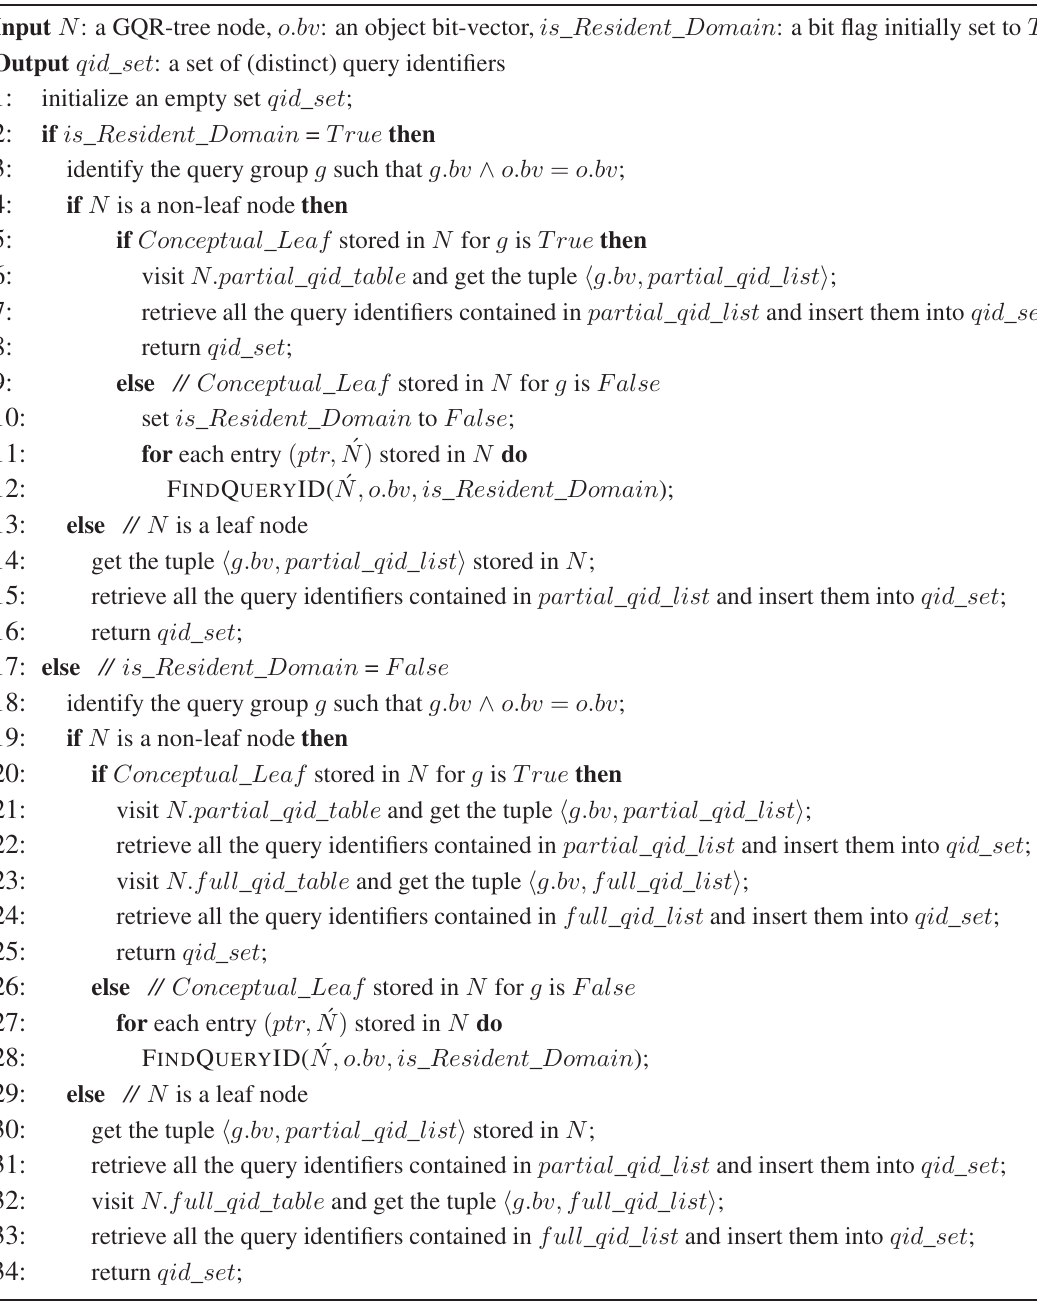
Algorithm 2 F IND Q UERY ID ( N, o.bv, is _ Resident _ Domain